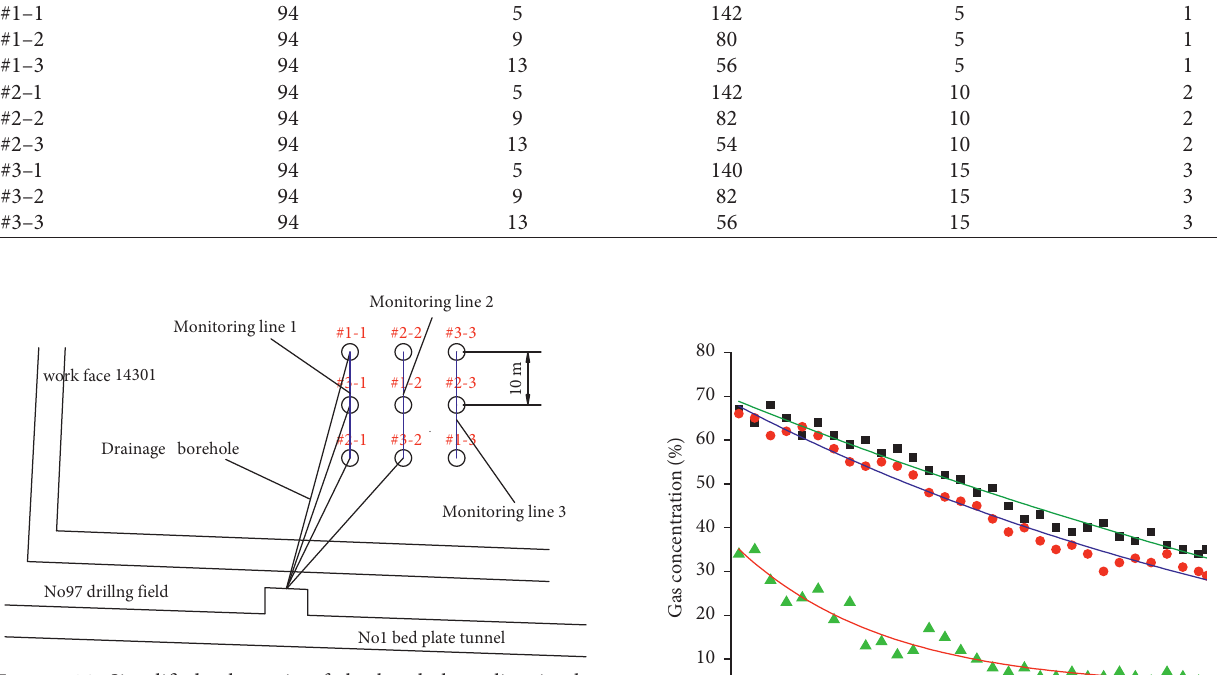
Figure 14: Simplified schematic of the borehole sealing in the drilling field.